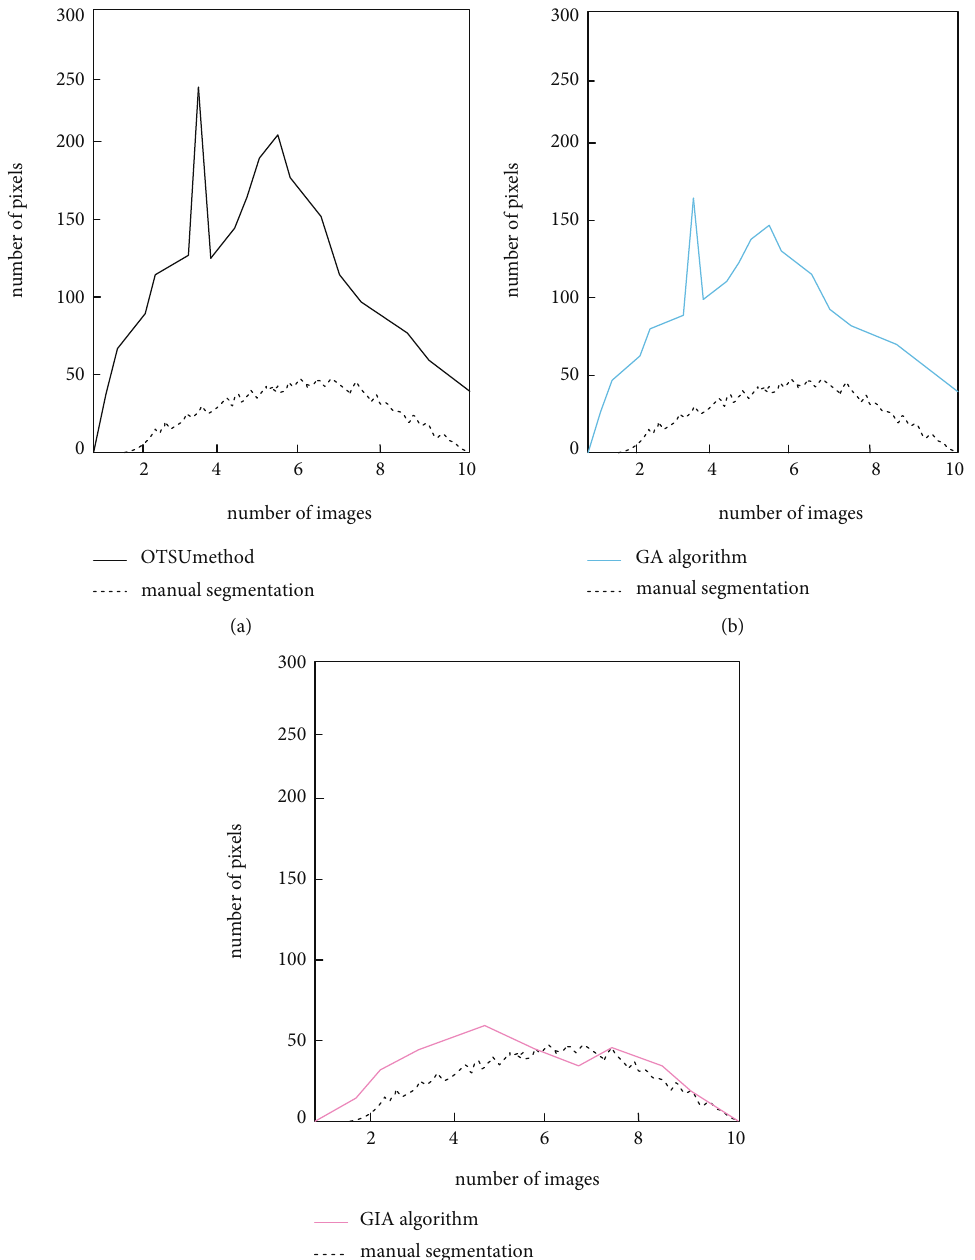
Figure 8: Comparison of the proximity of three methods of lung CT image segmentation and manual segmentation. (a) The proximity comparison between the segmentation e ff ect of the OTSU method and the manual segmentation. (b) The proximity comparison between the segmentation e ff ect of the GA method and the manual segmentation. (c) The proximity comparison between the segmentation e ff ect of the IGA method and the manual